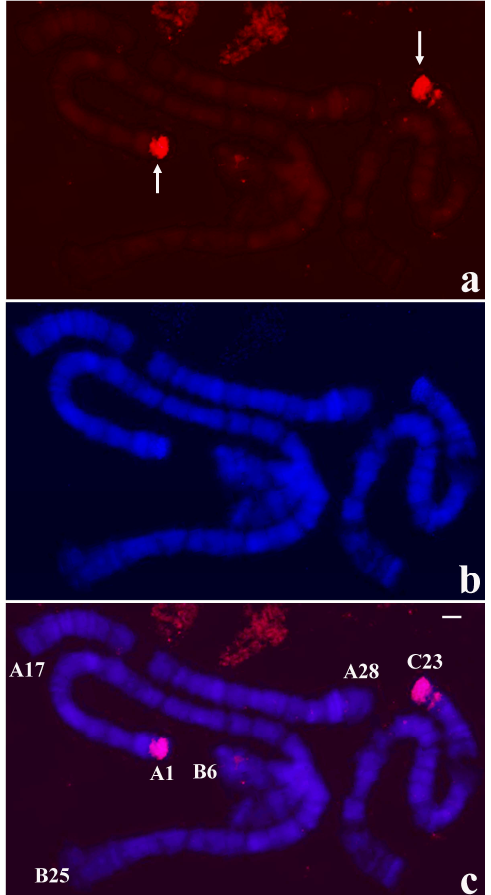
Figure 5. ( a ) Localization of the probe (red signal) synthesized with DNA from two microdissected chromosome ends A-1 and C-23 of T. pubescens in polytene chromosomes of T. pubescens . The arrows point to the main hybridization signals. ( b ) Chromosomes stained with DAPI and ( c ) the corresponding merged signals. Image superimposition shows chromosome end labelling at A-1 and C-23. Bar = 15 µ